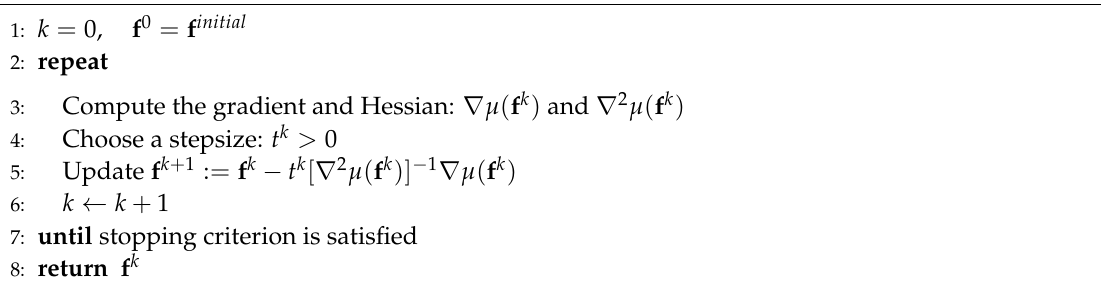
Algorithm 2 Newton’s method for solving the optimization.